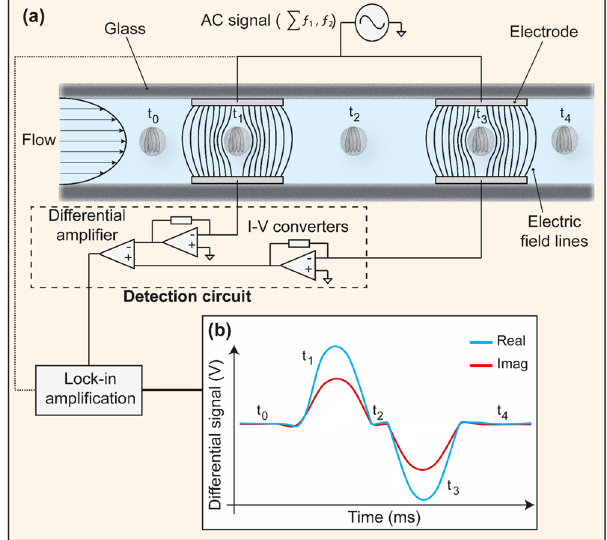
Figure 1. Schematic showing the microfluidic impedance cytometer. (a) The detection region consists of pairs of parallel facing electrodes which are 30 μ m wide and separated by 50 μ m. The electrodes are fabricated within a microfluidic channel which is 40 μ m wide × 30 μ m high. Pathogens suspended in PBS ( C. parvum illustrated) are driven through the channel by pressure-driven flow. Sinusoidal voltages at two discrete frequencies ( ƒ 1 ,